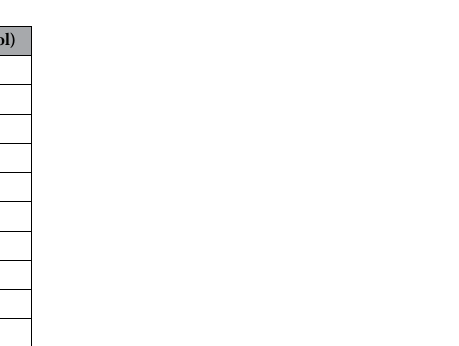
Table 8. Chemical interactions of compound 6g with amino residues of